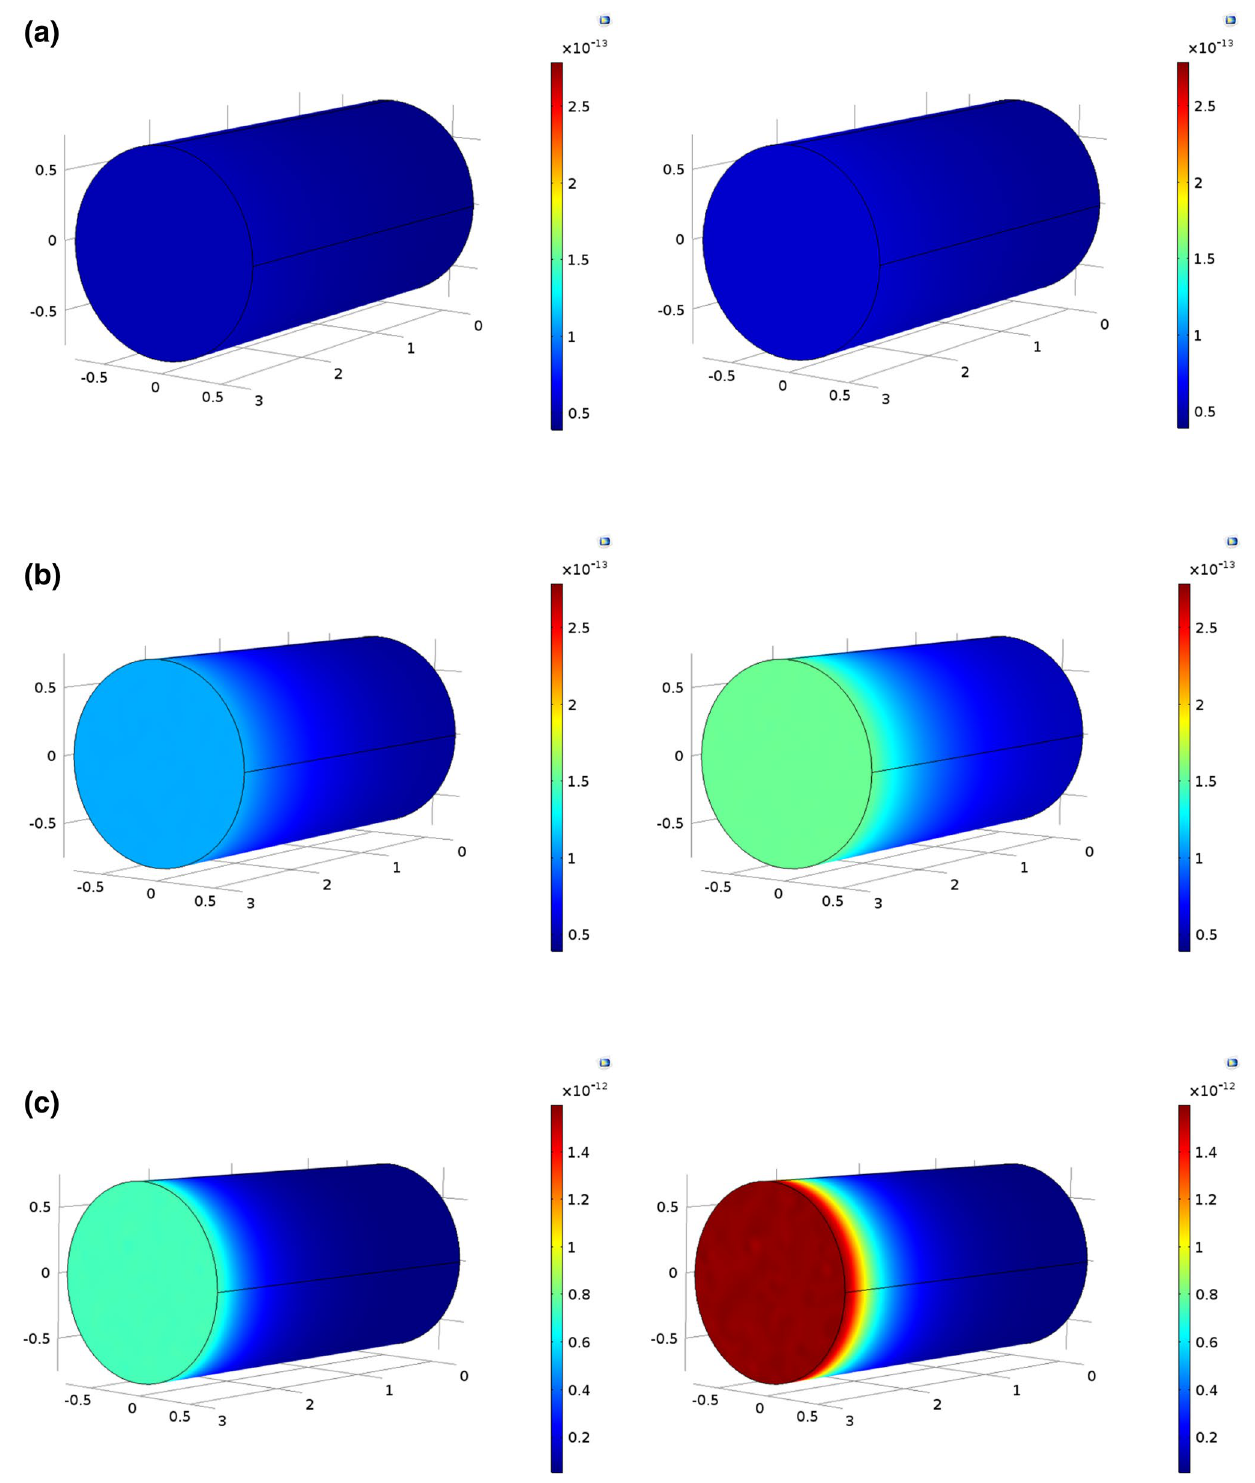
Fig. 5 Permeability distribution after 25 min (left) and after 35 min (right) of fluoroboric acid injection at a 25 °C, b 65 °C and c 105